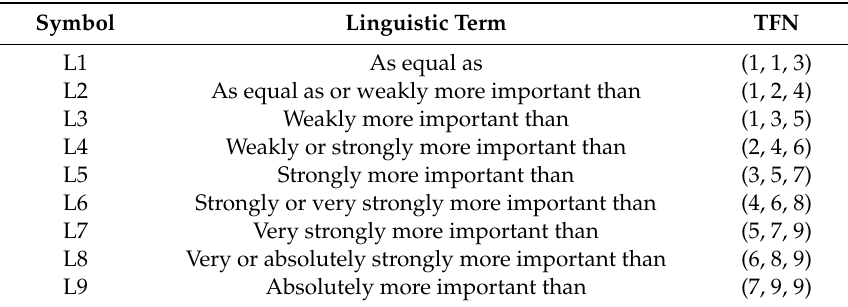
Table 2. Linguistic terms for expressing relative